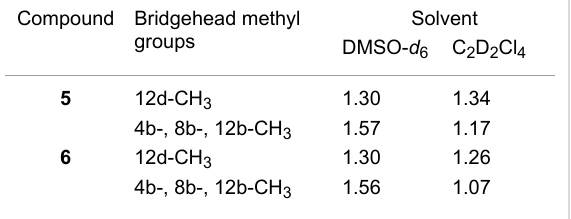
Table 1: Solvent effect on the chemical shifts ( δ ) observed in the 1 H NMR spectra (500 MHz) of the central (12d-) and the outer bridge- head (4b-, 8b-, 12b-) methyl groups of compounds 5 and 6